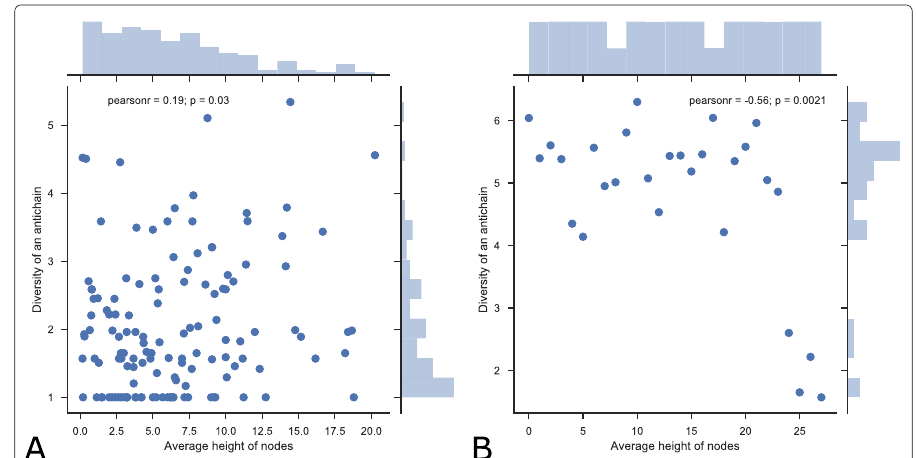
Fig. 8 Shannon’s diversity of nodes in antichains of the cora citation network. Each node has a label assigned to it, based on the topic the paper is on. There are seven topic in total. Two different antichain partitions are shown: a — successors and predecessors-based siblinarity antichains, b — height-based antichains (diversity calculated only for antichains, that are composed of at least five nodes). The horizontal axis is average heights of nodes in the antichain. The height antichains, with diverity values often close to the maximum value of seven, are much more diverse than the siblinarity